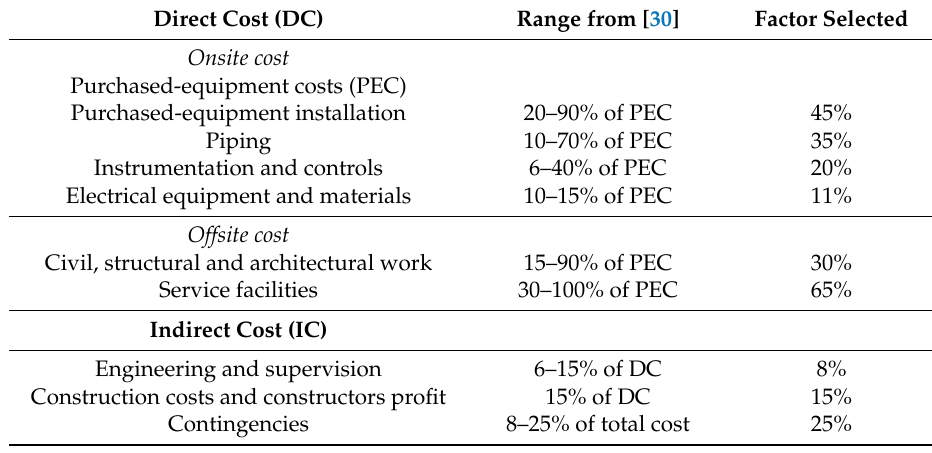
Table 1. Breakdown of the costs included in the total capital requirement [9] (Reprinted with permission from Pierobon, L; et al., Multi-objective optimization of organic Rankine cycles for waste heat recovery: Application in an offshore platform, published by Elsevier,